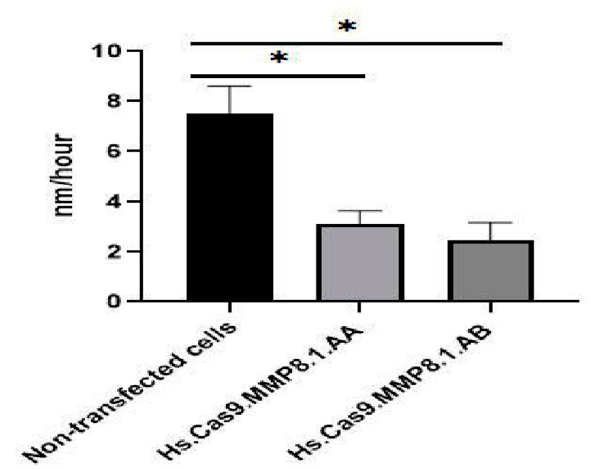
Figure 3. Effects of Hs.Cas9.MMP8.1.AA and Hs.Cas9.MMP8.1.AB gRNAs on rate of cell migration. The migration rate of A549 cells was followed up at 0 and 48 h. After treatment, the cell migration was analysed with ImageJ software and the rate was represented in nm/h from the initial gap between the two edges of each wound. The data were expressed as mean values ± Standard Error of the Mean (S.E.M) ( n = 3) (* p <0.05).